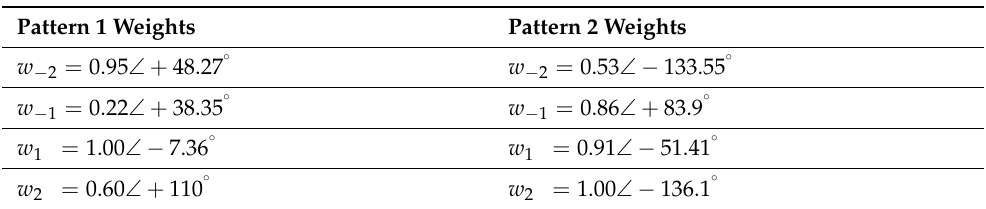
Table A5. Array weights of the conformal antenna on the cylindrical-shaped surface with r = 10 cm without coupling using (19).